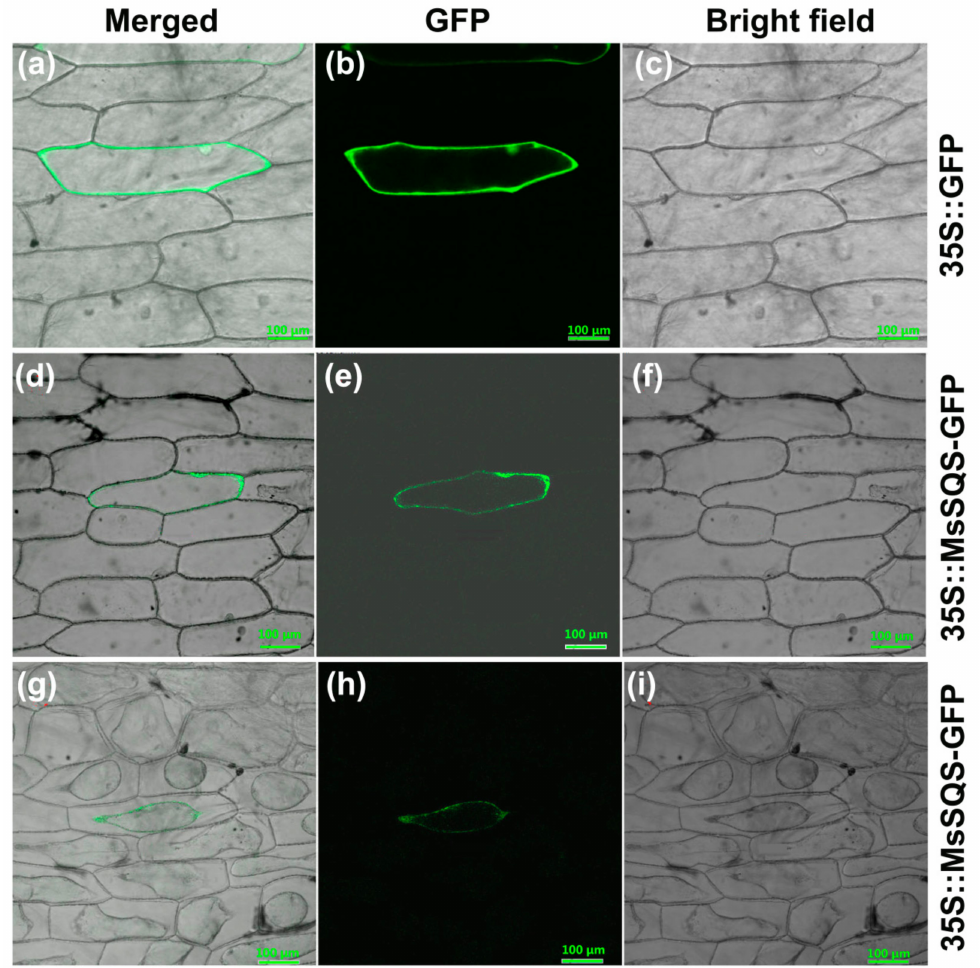
Figure 4. Subcellular localization of the 35S::MsSQS-GFP in onion epidermal cells. The MsSQS-GFP fusion construct and control vector pA7-GFP [35] were individually transformed into onion epidermal cells by microprojectile bombardment. Image was captured using a confocal laser scanning microscope (Olympus FV500). ( a – c ) Images of onion epidermal cells expressing 35S::GFP taken under GFP fluorescence ( b ) or in bright field ( c ), the merged one was shown in ( a ); ( d – f ) Images of onion epidermal cells expressing 35S::MsSQS-GFP taken under GFP fluorescence ( e ) or in bright field ( f ), the merged one was shown in ( d ); ( g – i ) Images of sucrose-treated (30%) onion epidermal cells expressing 35S::MsSQS-GFP taken under GFP fluorescence ( h ) or in bright field ( i ), the merged image was shown in ( g ). Bar = 100 µ